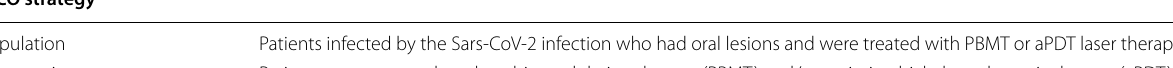
Table 1 PICO Strategy with inclusion criteria using on research PICO strategy Population Intervention